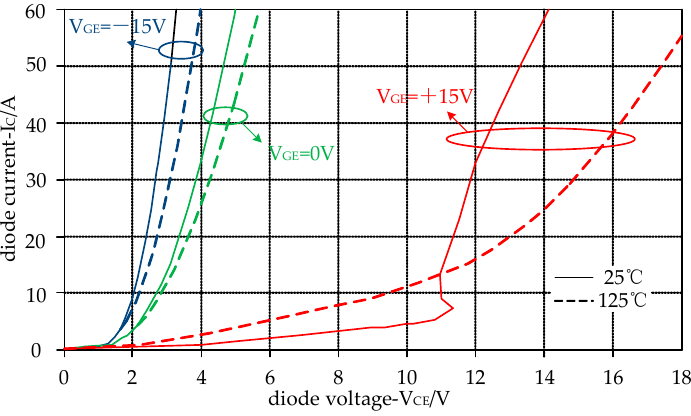
Figure 2. Static characteristic of RC-IGBT in the diode mode [20].